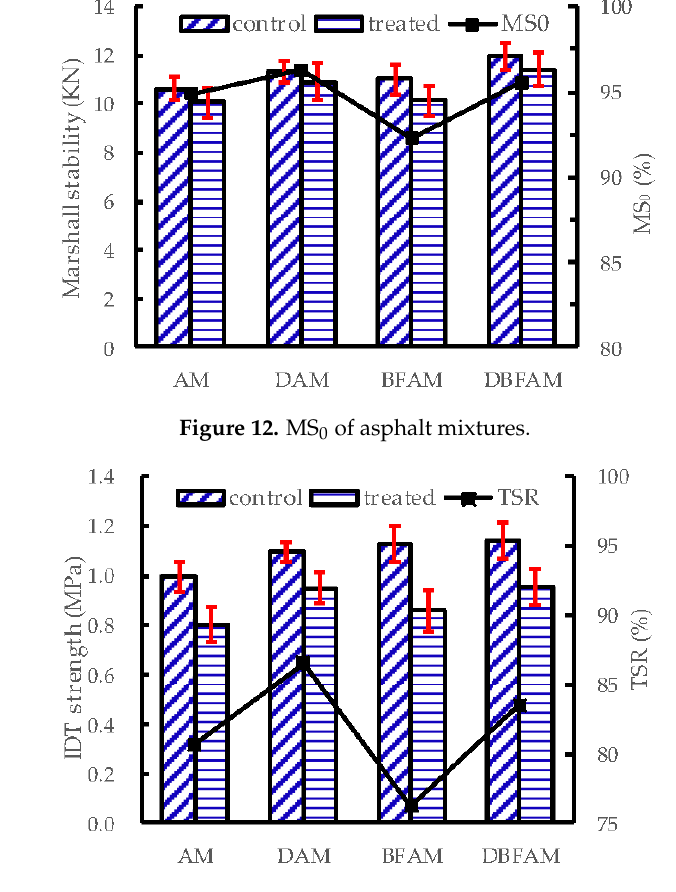
Figure 13. Tensile strength ratio of asphalt mixtures.